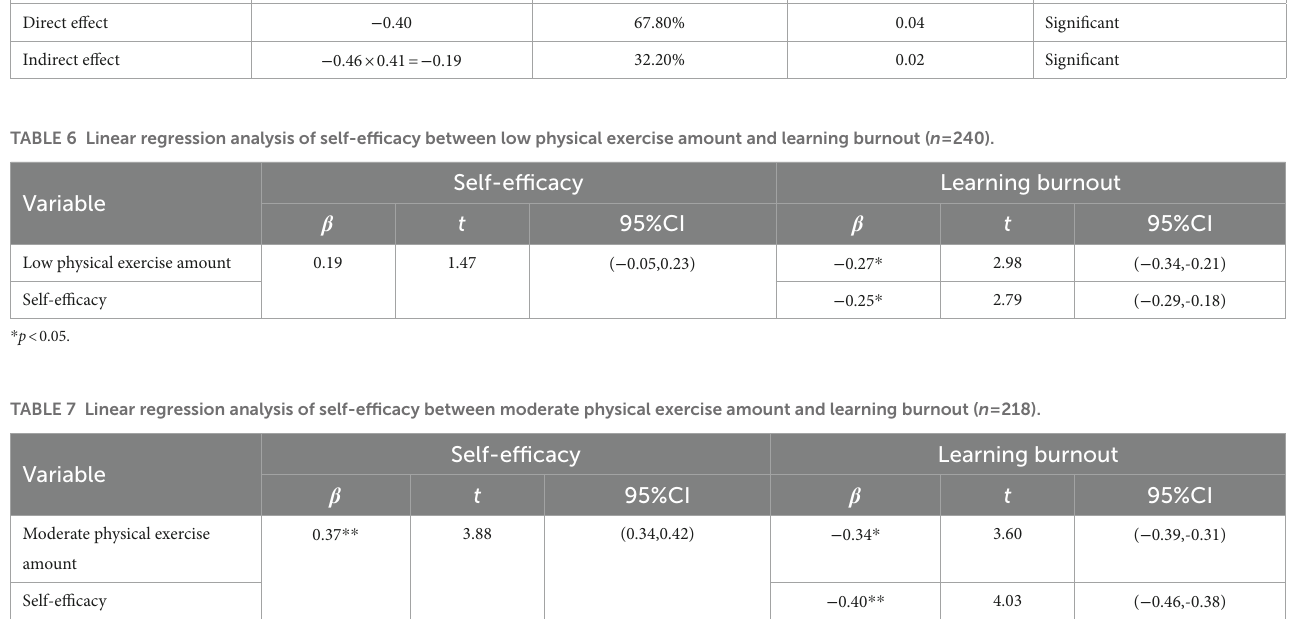
TABLE 5 The list of path effects.